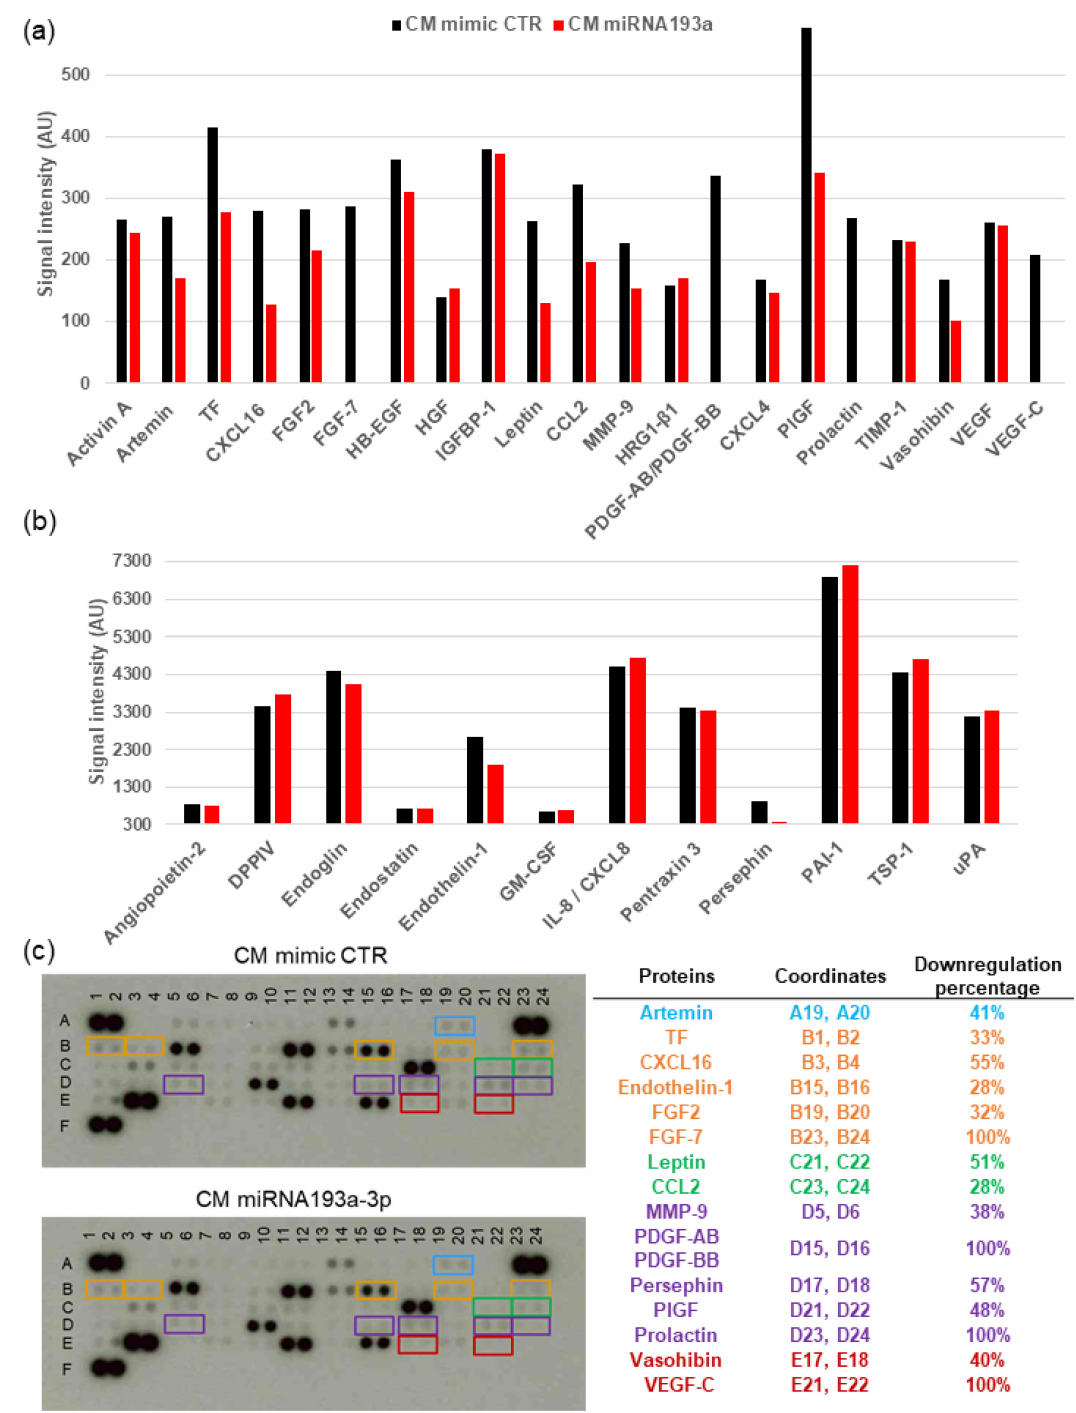
Figure 9. Secretome from miR193a transfected MCF-7 cells inhibits expression of pro-angiogenic proteins in VECs. Angiogenic protein profile array was performed using 200 µ g of protein from VECs cultured for 48 h in CM miRNA. Images were analyzed using ImageJ after background subtraction. Bar graphs show the average signal intensities of the framed spots on the array blots and include expression levels changes between 0 and 600 AU ( a ) and between 300 and 7300 AU ( b ). Representative array blots after an exposure time of 5 min ( c ). The table on the right of the array blots lists the most down-regulated proteins and the coordinates for their color marked location on the